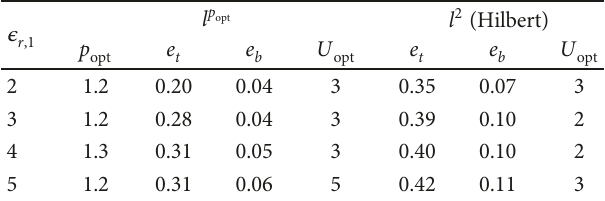
Table 1: Average relative errors ( e iterations U